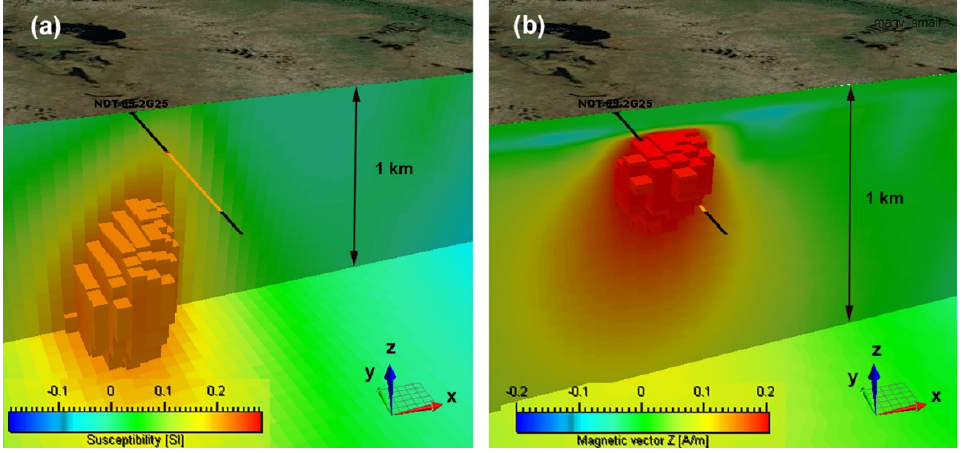
Figure 11. Comparison of 3D inverse models with drilling results. Left panel ( a ) shows the volume image of the inverse susceptibility model. Right panel ( b ) presents the volume image of the vertical component of the magnetization vector. The black–yellow–black solid line shows the location